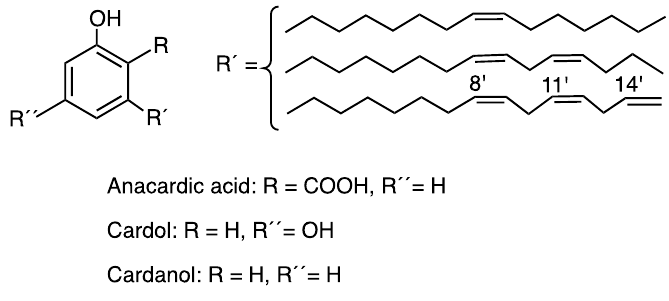
Figure 1. Chemical structures of the main constituents from Brazilian cashew nut shell liquid.